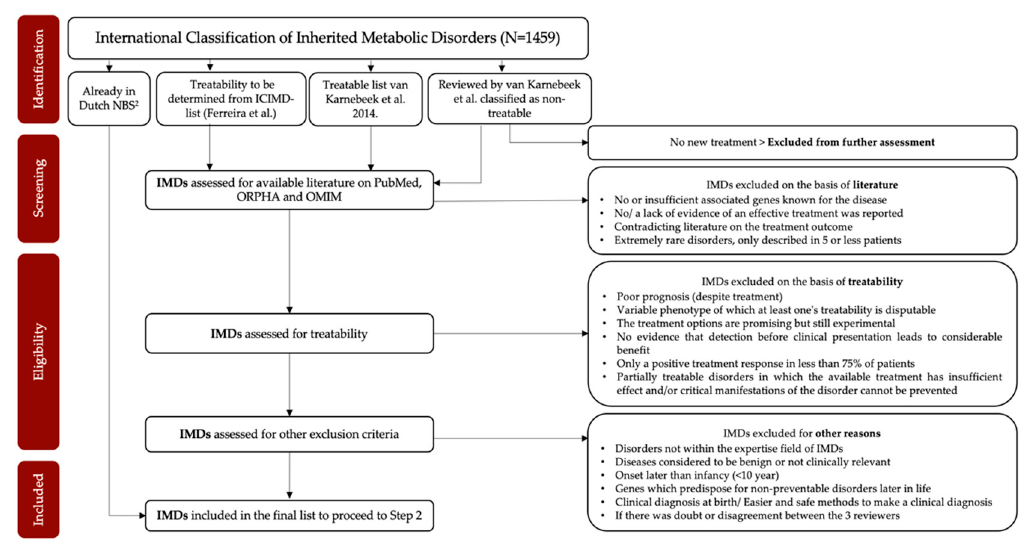
Figure 2. Preliminary flowchart of the selection process of Step 1.